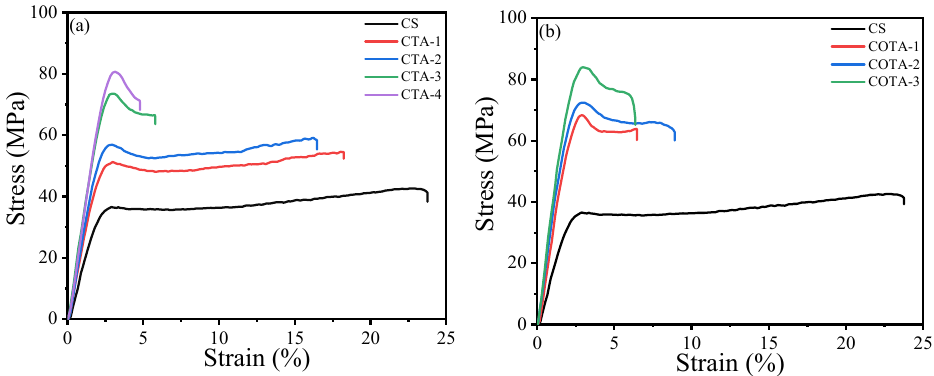
Figure 8. ( a ) Stress–strain curves for CS and CTA films; ( b ) stress–strain curves for CS and COTA films. Table 3. Mechanical properties of CS, CTA, and COTA films.